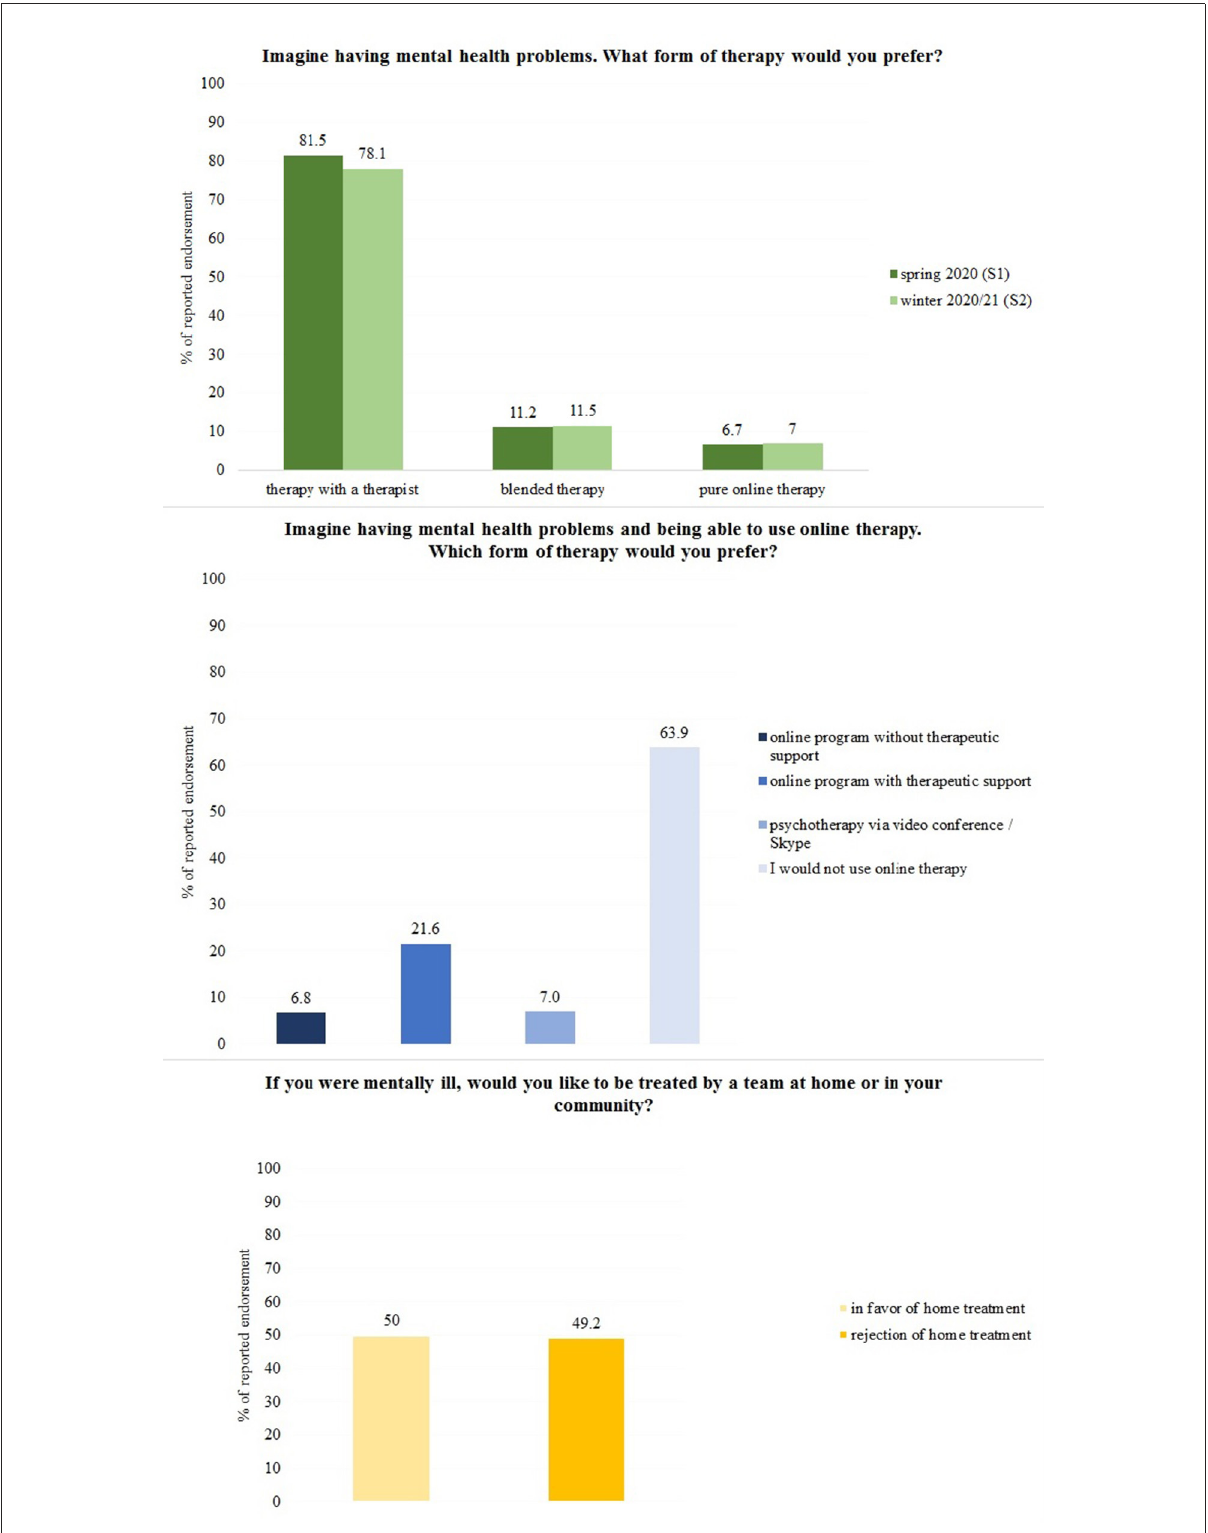
FIGURE1 Frequency of responses of participants distributed on the three dependent